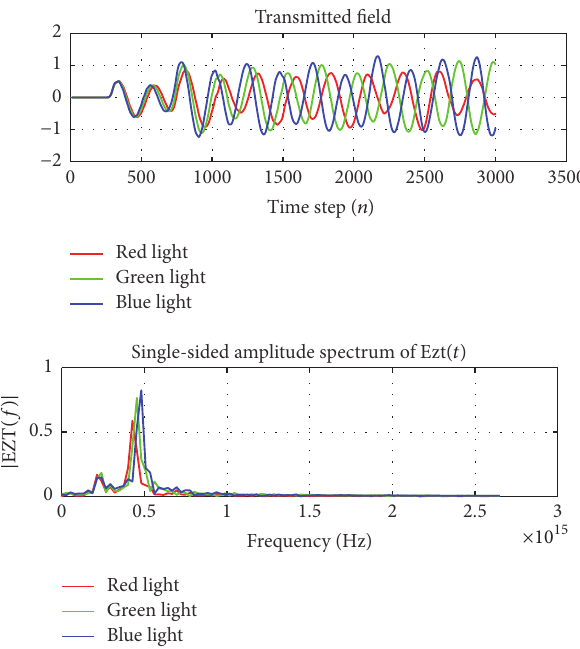
Figure 15: Field transmitted into the cloaking slab and equivalent amplitude spectrum versus frequency for red, green, and blue light corresponding to conditions in Table